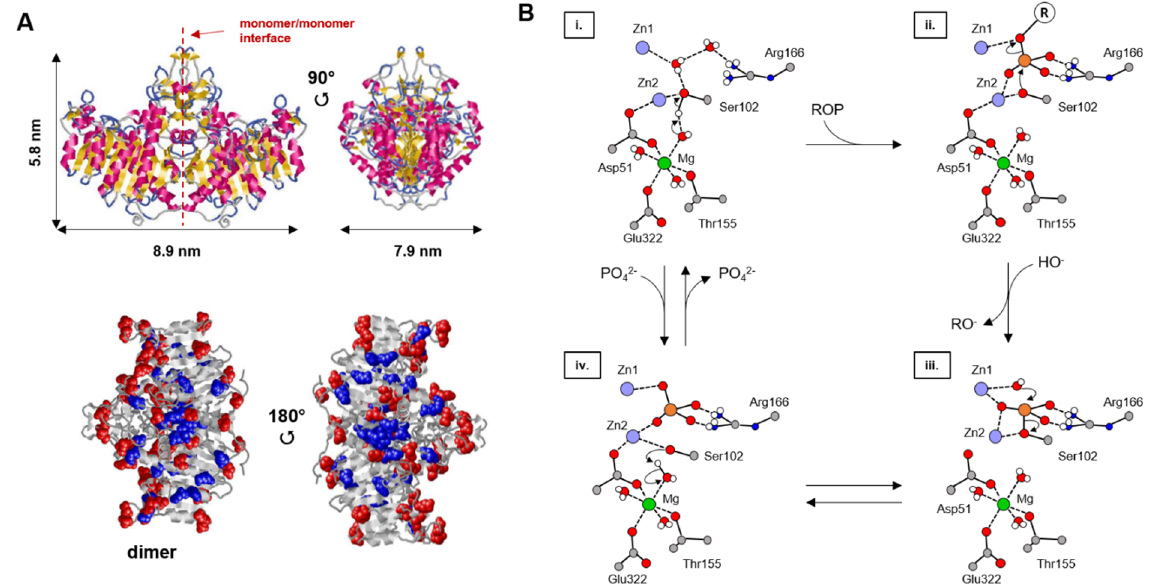
Figure 3. ( A ) Three-dimensional structure of ALP (PDB, code “P19111”). Different views showing the dimensions of the homodimer and the distribution of the superimposed residues, Glu (in blue) and Asp (in red) amino acids (adapted from [118]). ( B ) Mechanism of the enzymatic process (adapted from [117]). Only a few hydrogen atoms have been represented. During the first step, (i → ii), the hydroxide ion bound to the magnesium ion deprotonates the oxygen gamma of Ser102. During the same step, the phosphomonoester substrate (ROP) binds to the two zinc ions and to the guanidinium group of Arg166. Then, during (ii → iii), the deprotonated gamma oxygen of Ser102 acts as the nucleophilic group in the substitution where RO - is the leaving group. Then, during (iii → iv), a hydroxide ion enters the enzymatic site and is coordinated to Zn1. It then attacks the phosphorus atom of the phosphoserine that had been generated in the previous step through a nucleophilic substitution where the gamma alkoxide of Ser102 is the leaving group. Finally, during (iv → i), the alcohol is regenerated on the serine, as well as the hydroxide ion on the magnesium ion. During this last step, a Pi ion is generated.